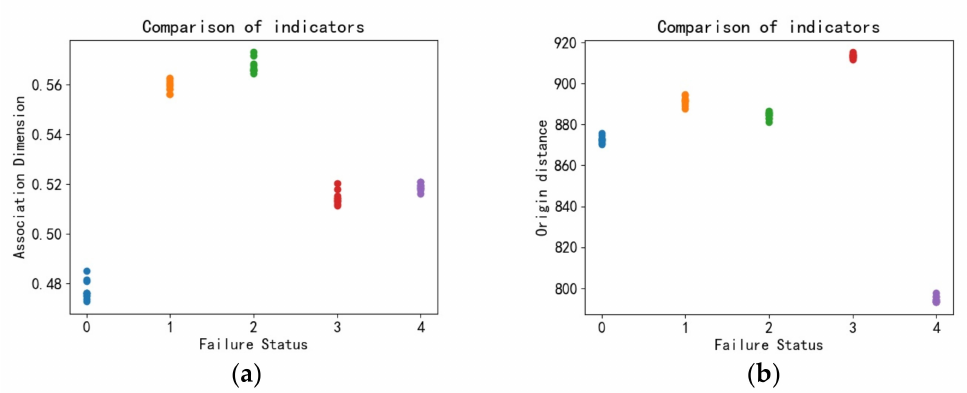
Figure 11. Overall characteristics of different fault phase trajectories D , E distribution: ( a ) association dimension D ; ( b ) origin moment E